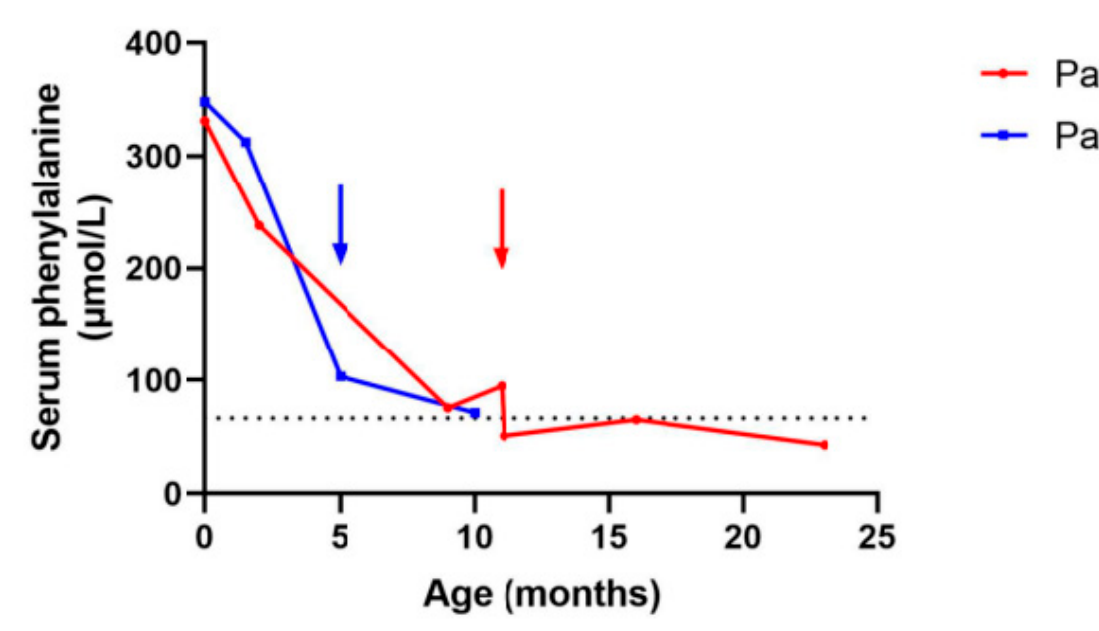
Figure 2. Dynamic representation of the phenylalanine levels in our patients. The dotted line represents the normal upper limit of serum phenylalanine concentrations (66.5 µmol/L). The arrows represent the start of the specific treatment (Sapropterin).